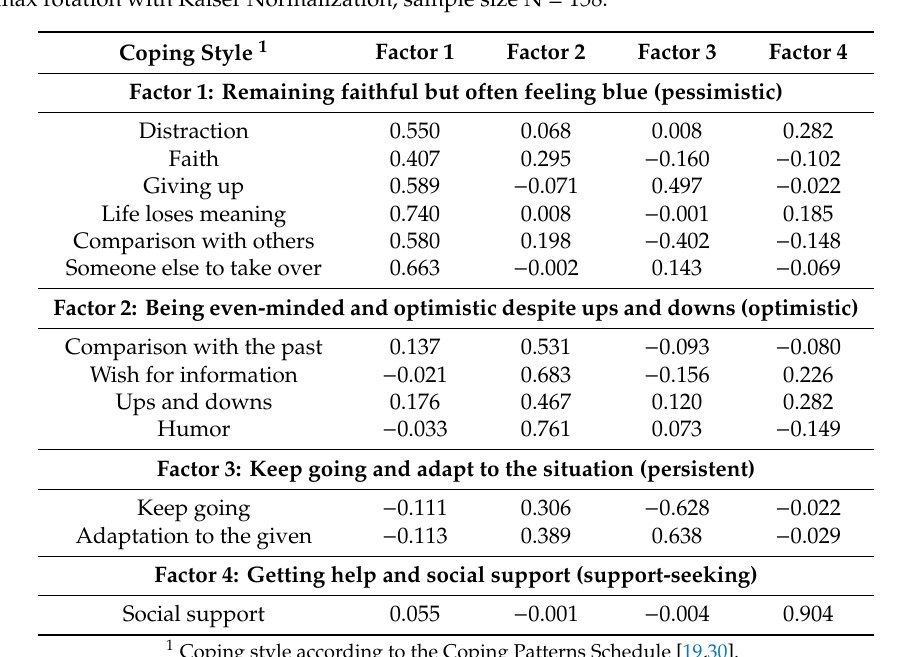
Table 2. Factor analysis of coping styles, using principal component analysis as extraction method and varimax rotation with Kaiser Normalization, sample size N =